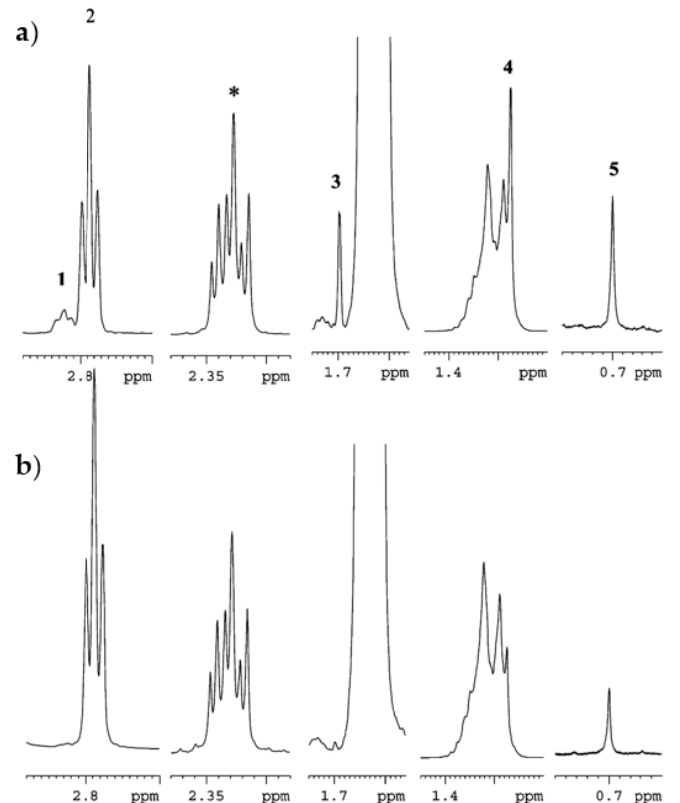
Figure 4. 1 H NMR resonances selected for statistical analyses in the 600.13 MHz 1 H spectrum of an ( a ) olive oil (top trace) and ( b ) a hazelnut oil. Peaks: 1, diallylic protons of linolenic acid, 2.82 ppm; 2, diallylic protons of linoleic acid, 2.78 ppm; 3, a signal due to squalene, 1.69 ppm; 4, methylenic protons of palmitic and stearic fatty chains, 1.27 ppm; 5, methyl-18 of β -sitosterol, 0.70 ppm. The reference peak at 2.32 ppm is also reported ( ∗ ) (Reprinted with permission [26] from American Chemical Society, Copyright 2009).